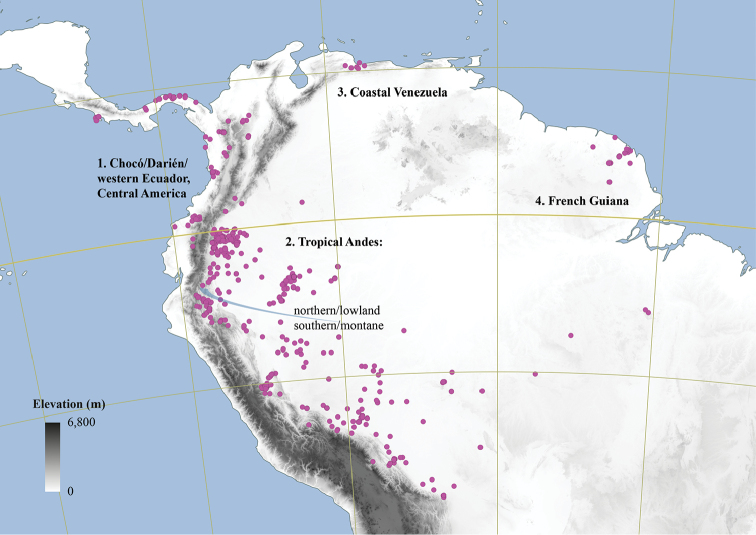
Distribution map of Cremastosperma showing the four disjunct areas of the distribution: 1 the Chocó/Darién/western Ecuador region north into Central America 2 the tropical Andes (including a rough demarcation between areas occupied by northern/lowland and southern/montane clades) 3 coastal Venezuela 4 French Guiana.